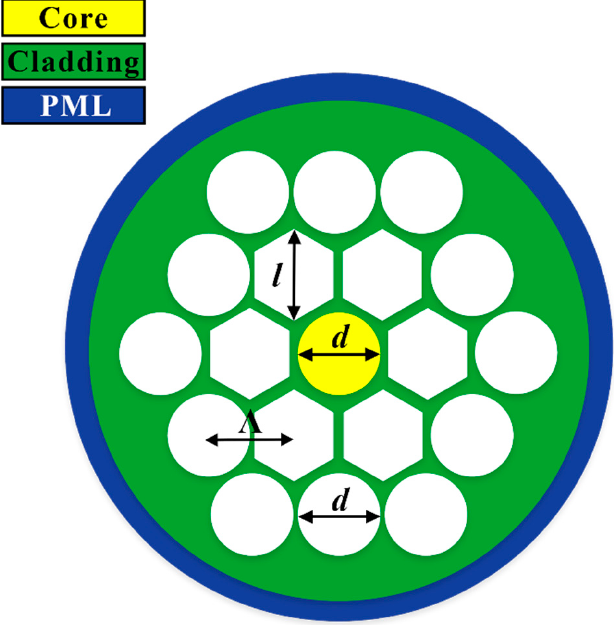
Figure 1. Proposed PCF design for chemical sensing.